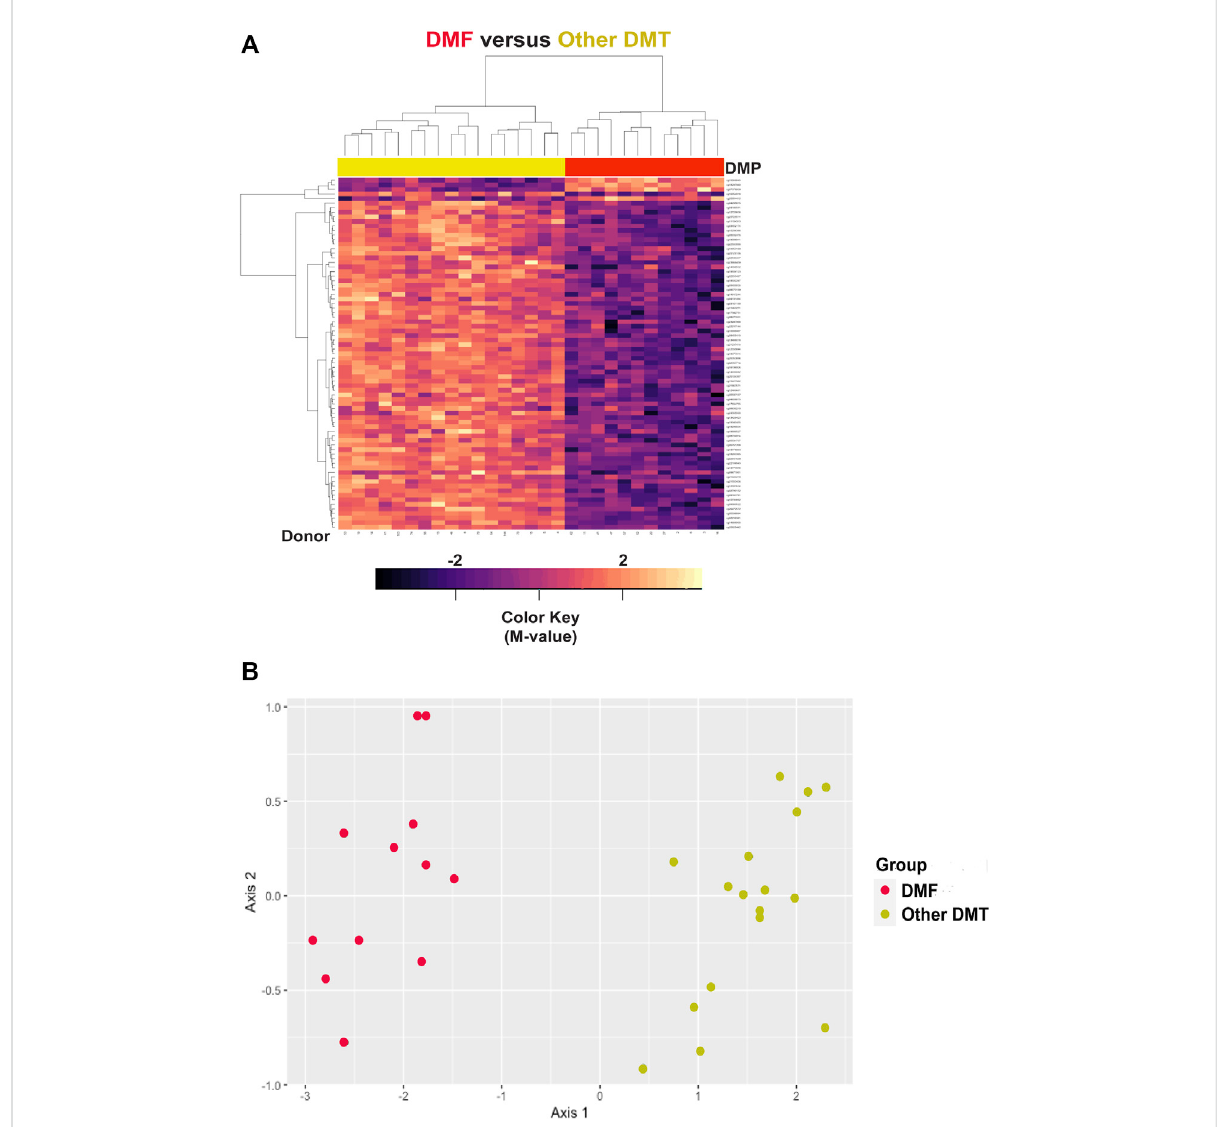
FIGURE 7 Hierarchal clustering and multi-dimensional scaling (MDS) analysis of differentially methylated regions associated with dimethyl fumarate treatment. (A) Heatmap is shown for hierarchal clustering analysis performed on differentially methylated loci within 77 differentially methylated loci within the top 10 differentially methylated regions (DMR) (Supplementary Table S23). The gene regions are: CLASP2, CLU, DOK3, GPR146, PARVB, PARVG, RAB34, SLC11A2, TAGLN3, and WBP1L. In the heatmap, dimethyl fumarate treatment is designated by red (n = 12), and controls by yellowatthetopoftheheatmap(n=17).Blue/purpledesignatesrelativedemethylationandorange/redincreasedmethylationataspeci fi cCpGsite. (B) MDS analysis showed a goodness of fi t of